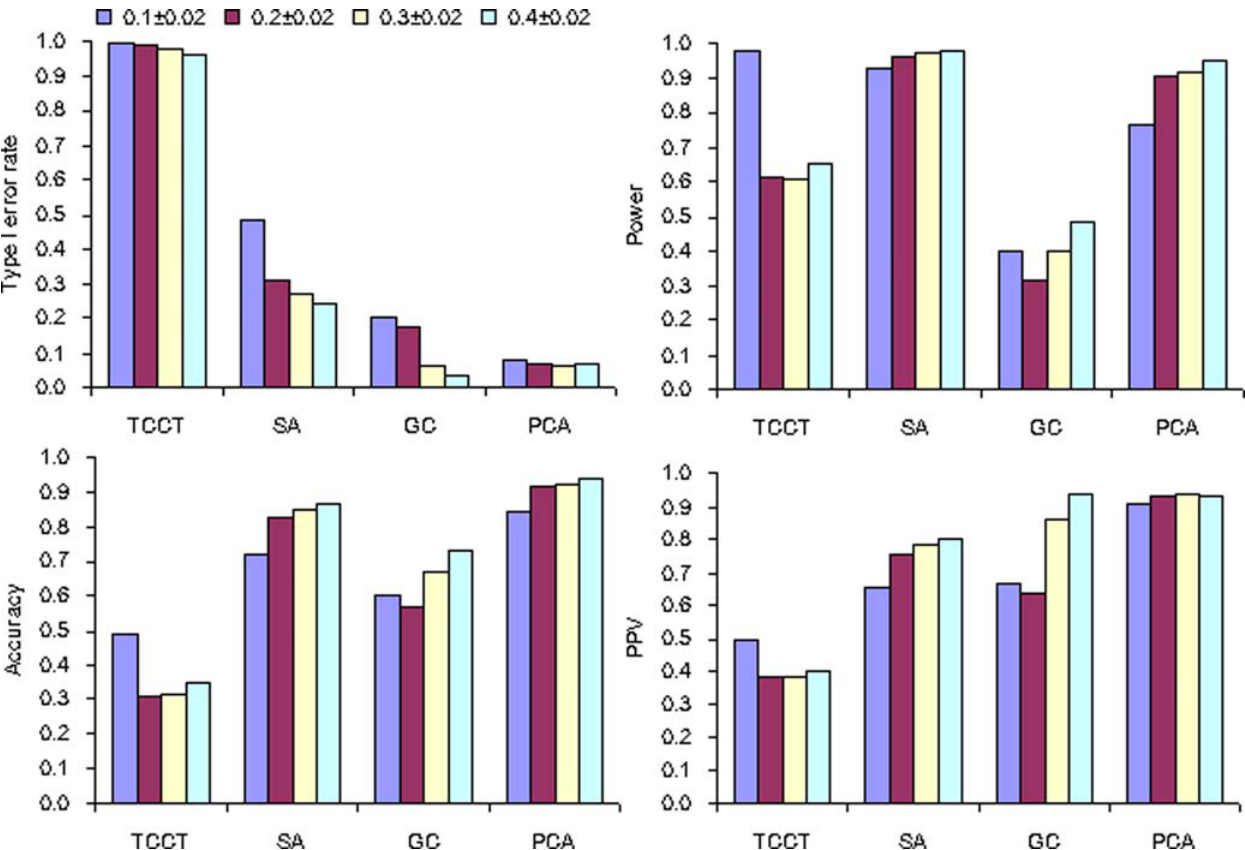
Figure 3. Performance of the four analytical methods in stratified populations with frequencies of disease susceptible allele varying from 0.10 6 0.02 to 0.40 6 0.02 (stratification level=0.5 2 0.1, sample size=1200 and number of AIMs=40).